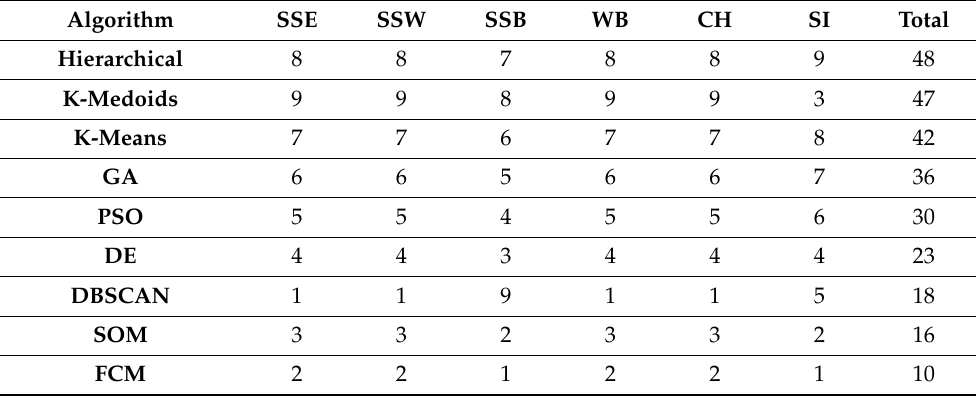
Table 2. Overall ranking using Borda count method considering different indexes and algorithm